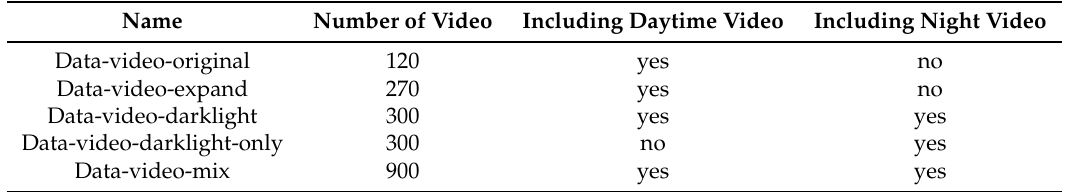
Table 1. Information of the dataset.